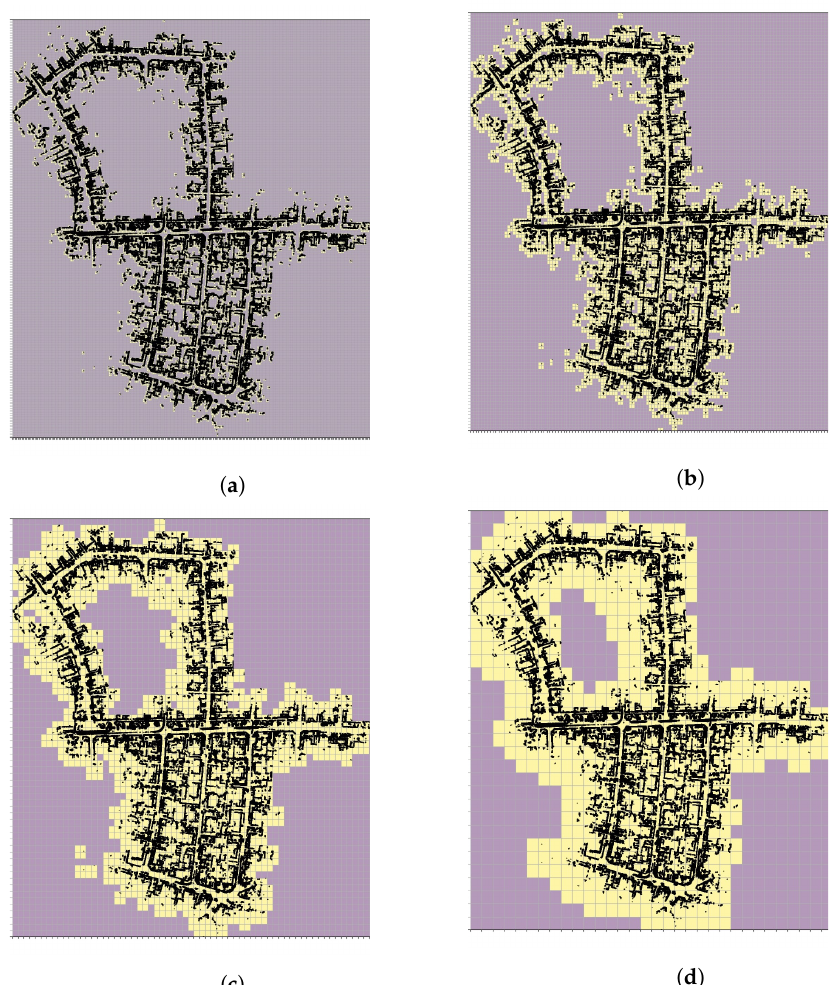
Figure 4. L9 resolution. ( a ) L6 resolution, ( b ) L7 resolution, ( c ) L8 resolution, ( d ) L9 resolution.